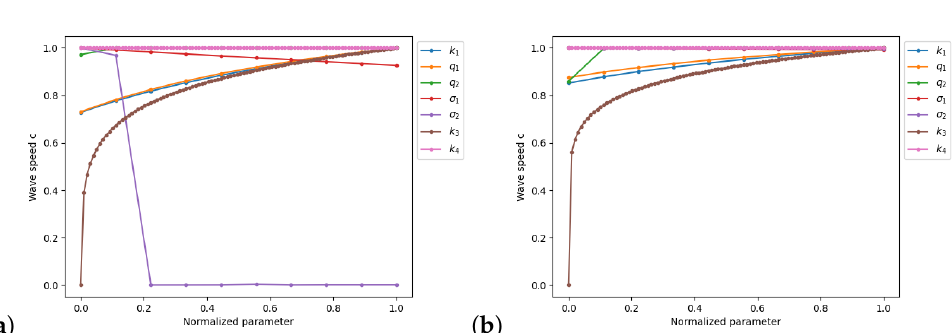
Figure 4. The dependence of the wave speed in the system (1)–(5) on parameters. ( a ) All the parameters are in their estimated ranges from Table 1, and the ranges are projected to the [ 0,1 ] interval by a linear function. Fixed parameters are the same as listed in Figure 3. ( b ) Different values for the fixed parameters (from Table 1); the results for q 1 correspond to Figure